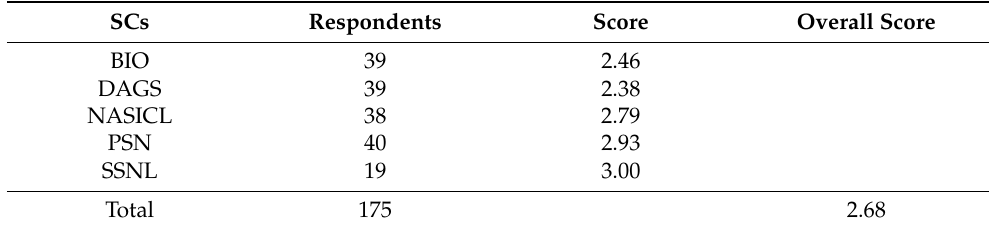
Table 2. The Reaction of farmers to the training.